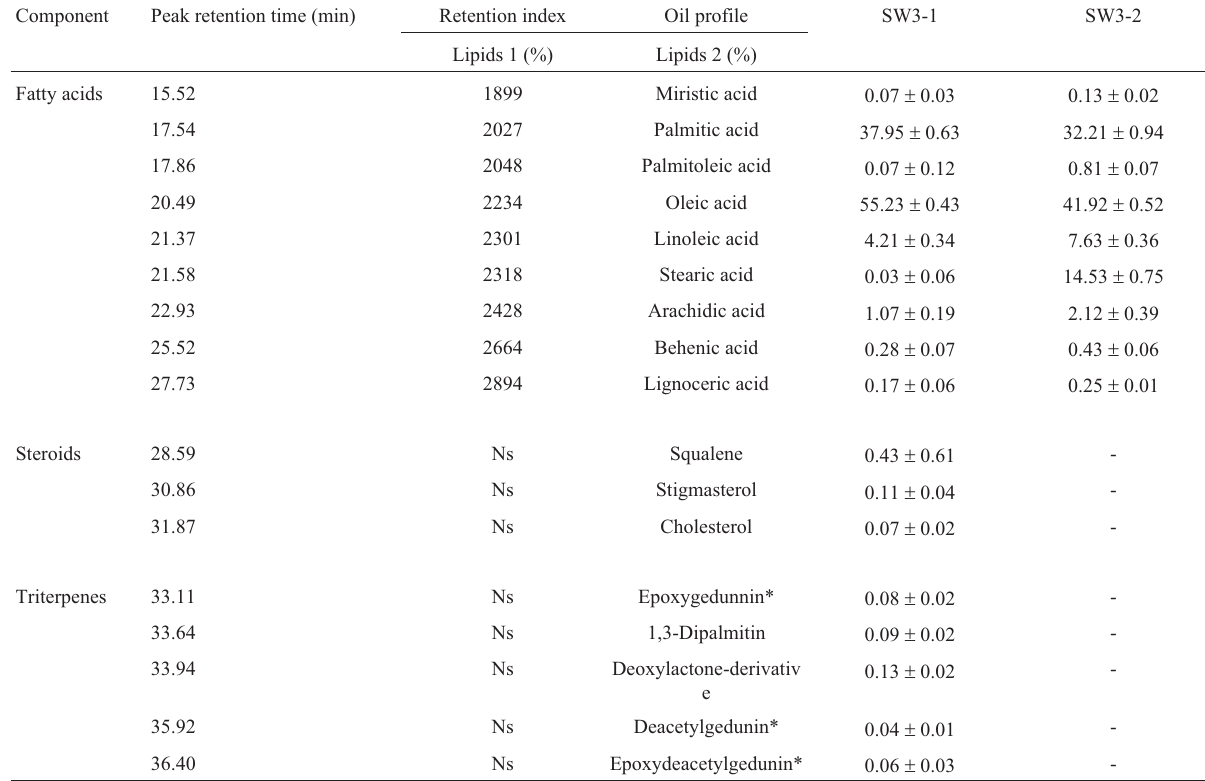
Table 2 - Profile of fatty acids, steroids and triterpenes present in two samples (SW3-1 and SW3-2) of andiroba oil. Component